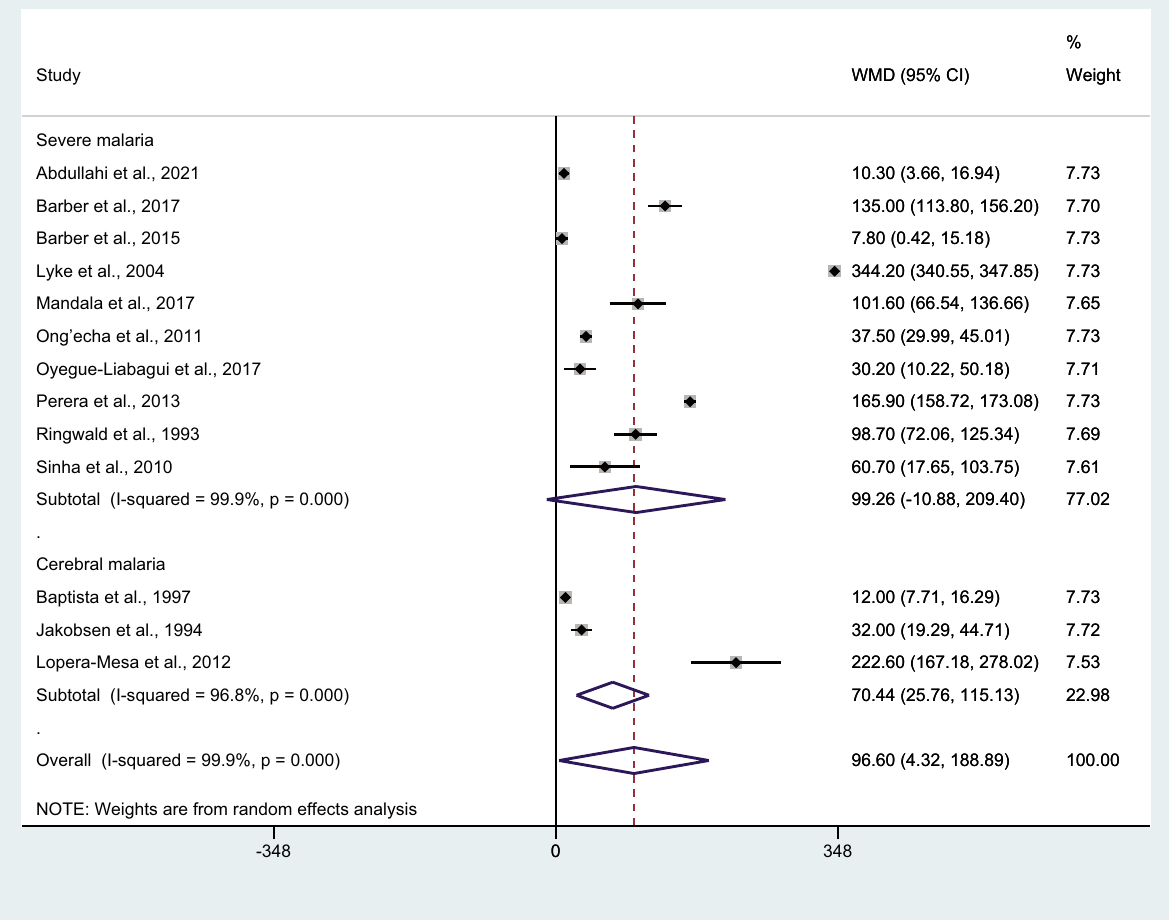
Figure 4. Differences in IL-6 levels between patients with severe malaria and non-severe malaria by complications. Abbreviation: WMD, weighted mean difference; CI, confidence interval; black diamond symbol, point estimate; solid line in the middle of the graph at 0, zero effect size; Dashed red line: pooled WMD between the two groups; I 2 , level of heterogeneity; P = 0.00 or less than 0.05, significant